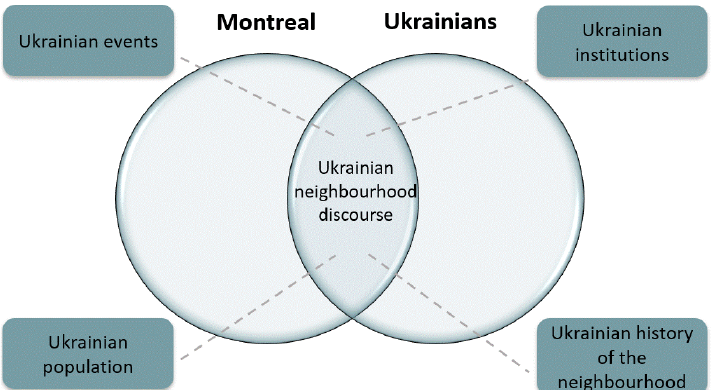
Fig. 3. Shared discourse between the City of Montreal and the Ukrainian community of